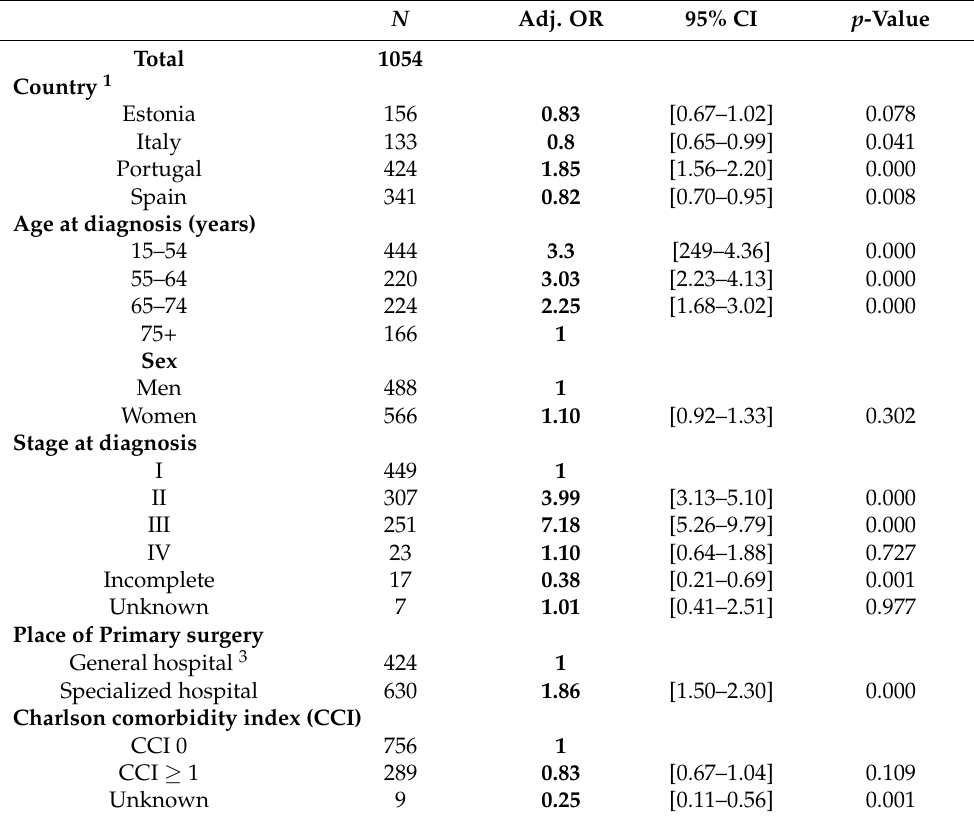
Table 3. Number of cases ( N ) receiving Sentinel Lymph Node Biopsy and adjusted Odds Ratios (OR) with 95% Confidence Intervals (CI), for cutaneous melanoma patients diagnosed in 2009–2013 in four European countries. N Adj. OR 95% CI